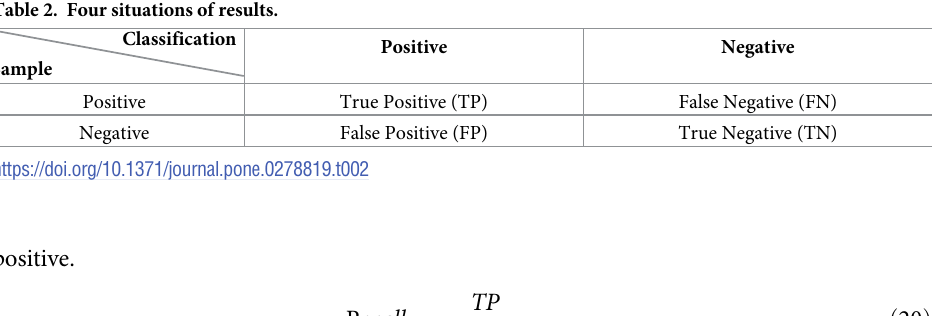
Table 2. Four situations of